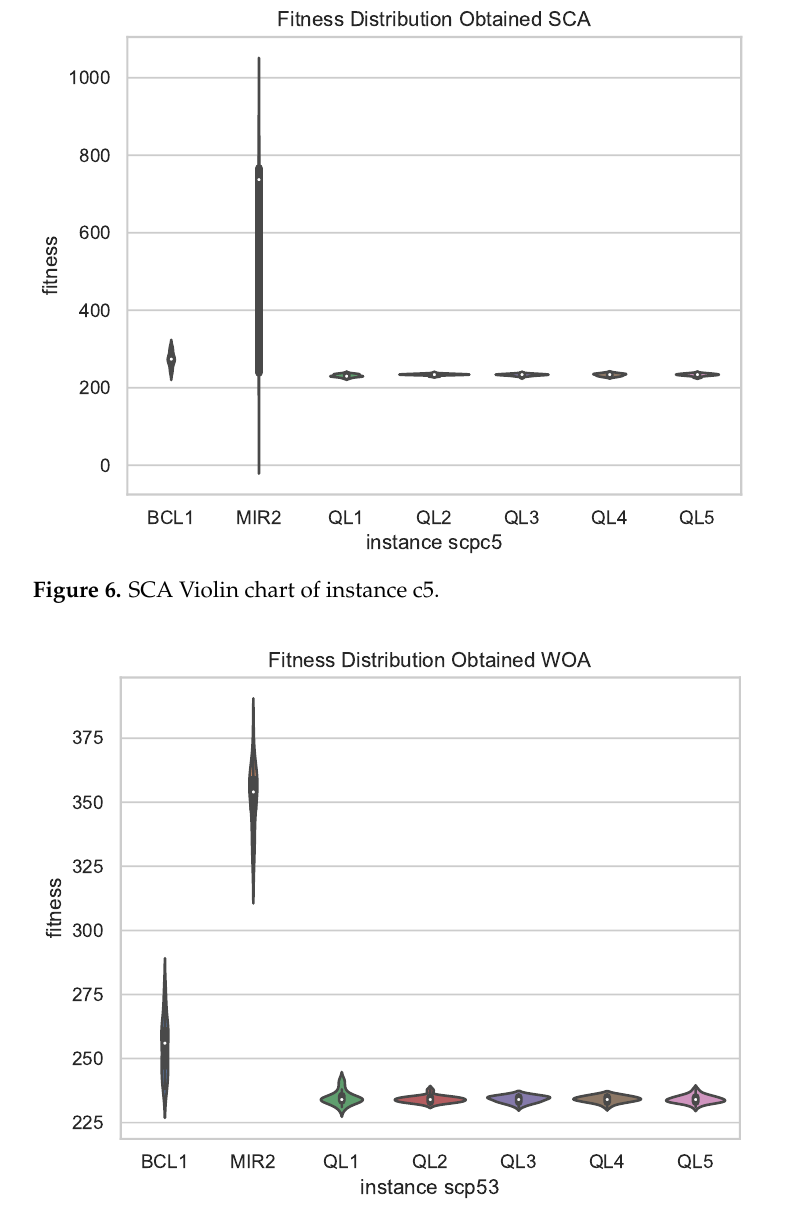
Figure 7. WOA Violin chart of instance